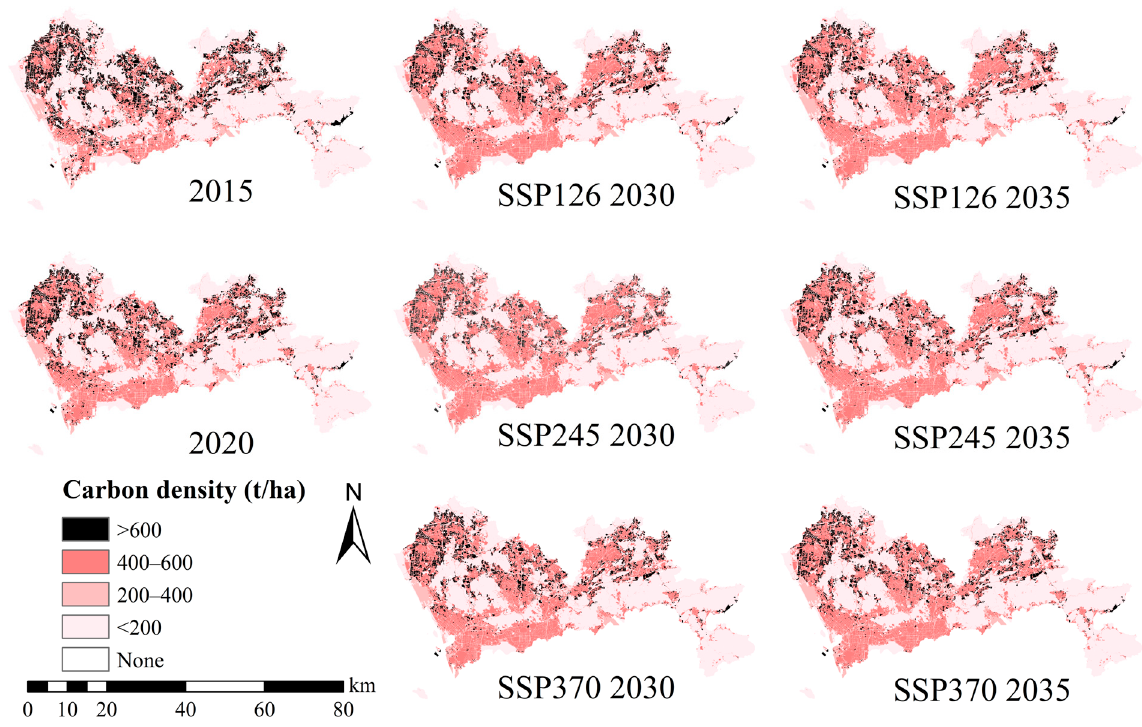
Figure 6. The distribution of land use carbon density under SSP-RCP scenarios in Shenzhen.